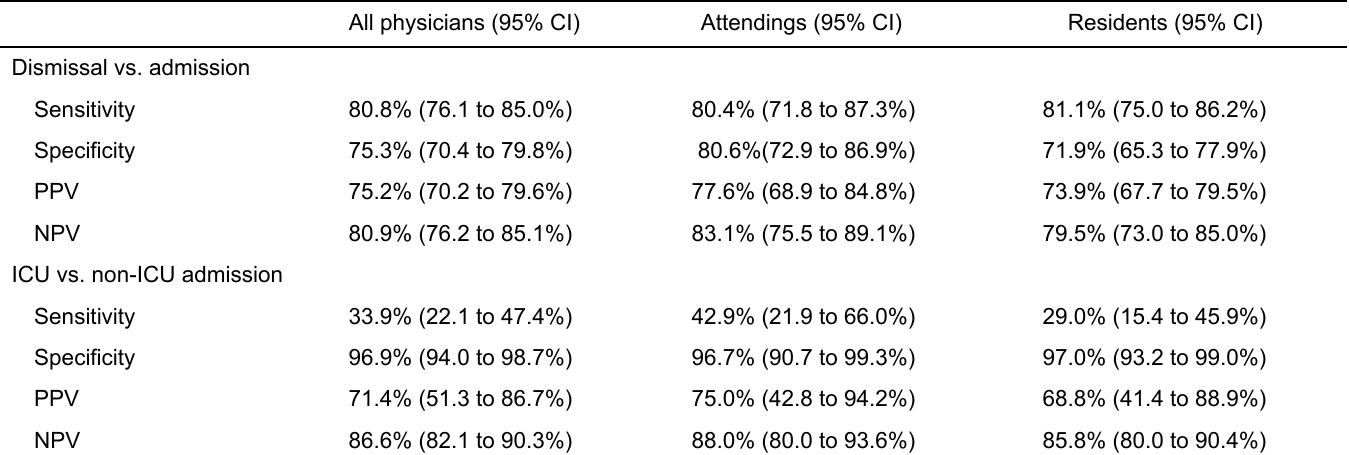
Table 2. Performance of the prediction of